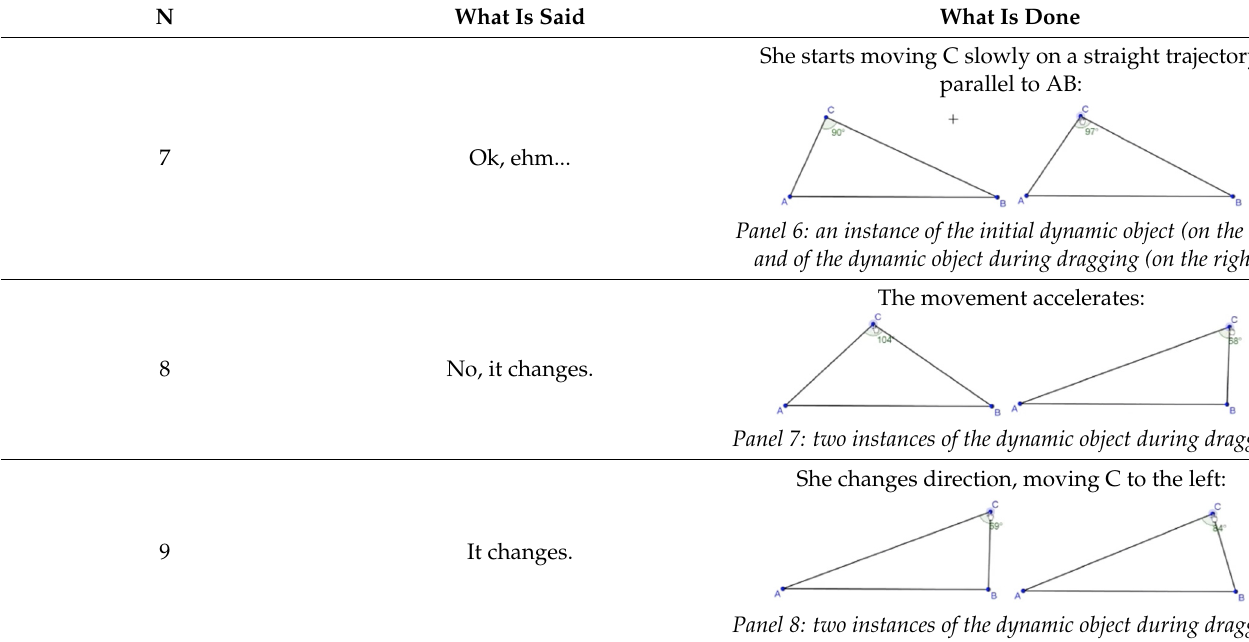
Table 5. Excerpt 3 from Ilaria’s Dynamic Geometry Environment (DGE) exploration.